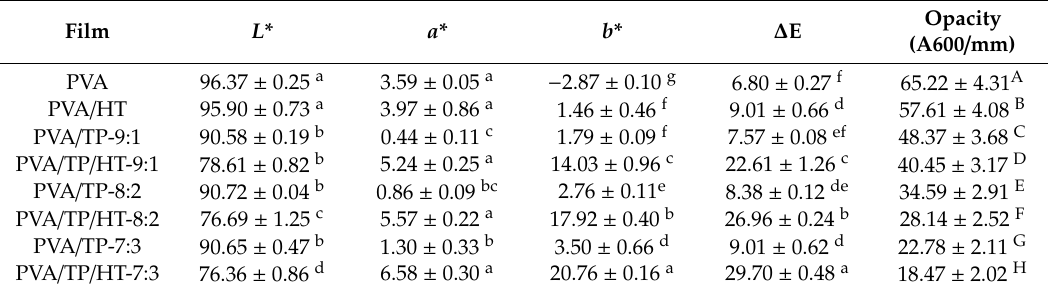
Table 2. E ff ect of the heat treatment and incorporation of TP on the color and transparency of nanofiber